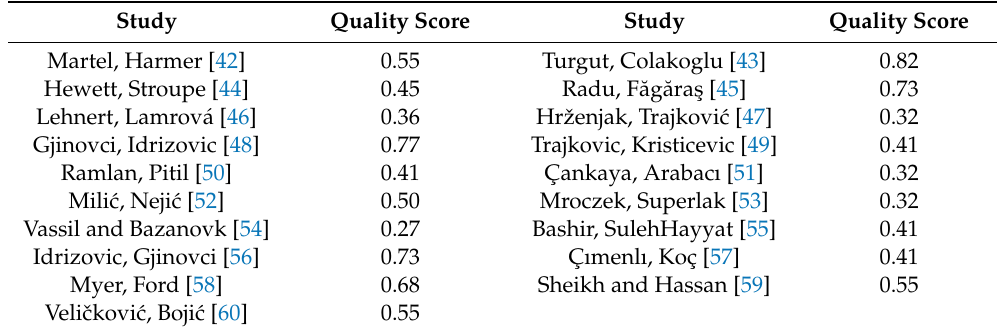
Table 1. Quality score for the included